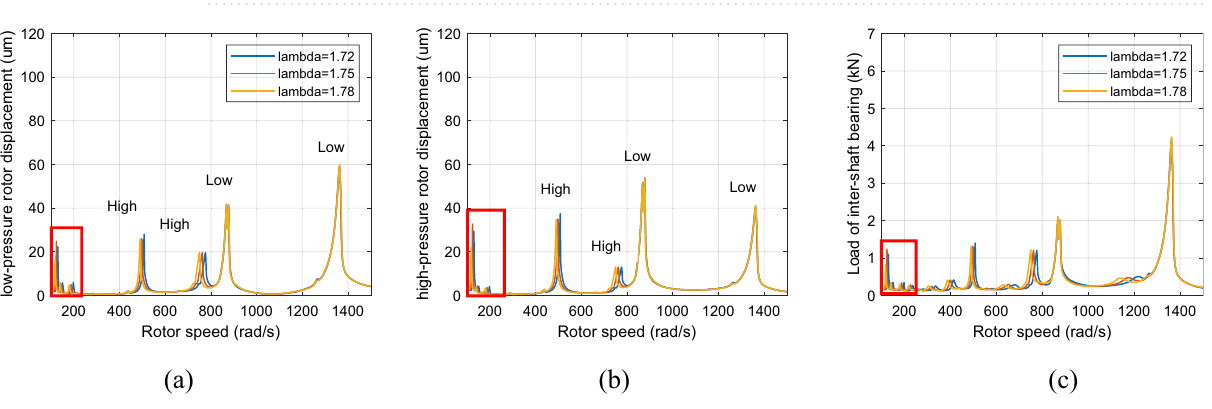
Figure 8. Amplitude-frequency response curve with defect (λ = 1. 72, 1. 75, 1. 78, F 0 = 0, A max = 200) ( a ) LP rotor ( b ) HP rotor ( c ) inter-shaft bearing’s